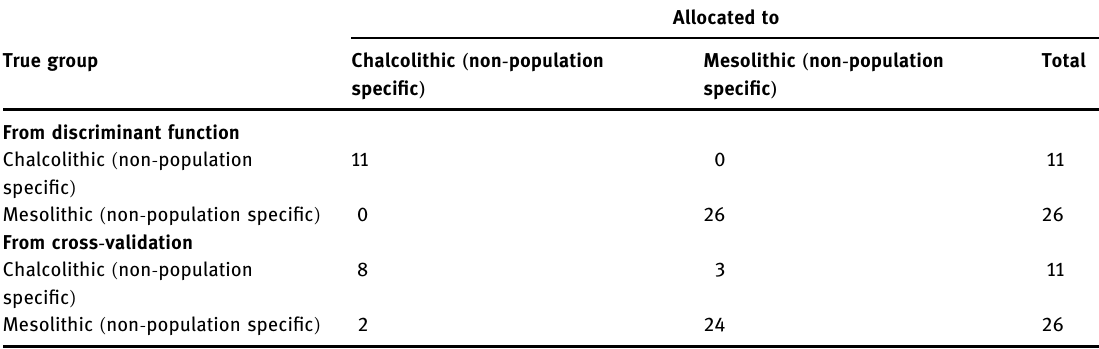
Table A3: DFA with cross - validation of the non - population - speci fi c reconstructed Chalcolithic sample vs the non - population - speci fi c reconstructed Mesolithic sample ( see details about reconstruction parameters in Materials and Methods